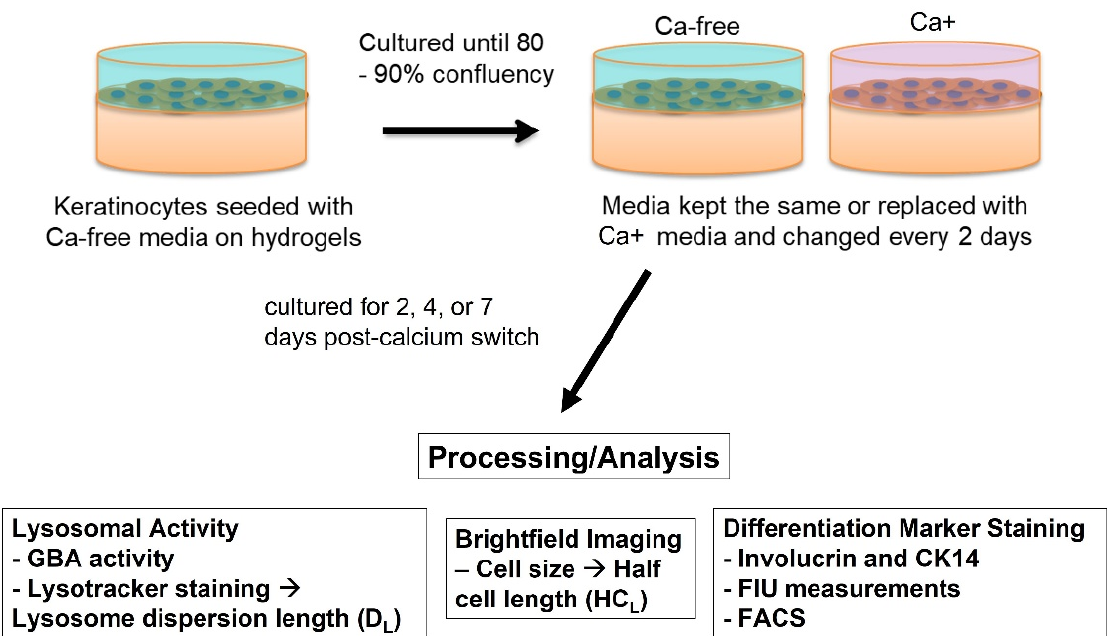
Figure 1. Schematic and flow chart of studies with keratinocytes seeded on either the well plate or on hydrogels. Calcium switch was utilized after reaching 80–90% confluency and then media was changed every 2 days. Half of the samples were cultured in Ca-free media. Keratinocytes were analyzed for lysosomal activity, cell size, and differentiation marker expression.